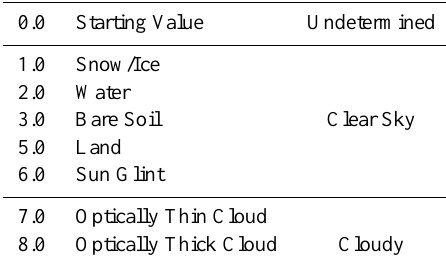
Table 4. Table of used indices for the MERIS pixel classification in the MICROS